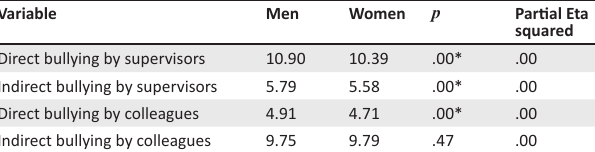
TABLE 6: Analysis of variance – differences in workplace bullying based on gender.